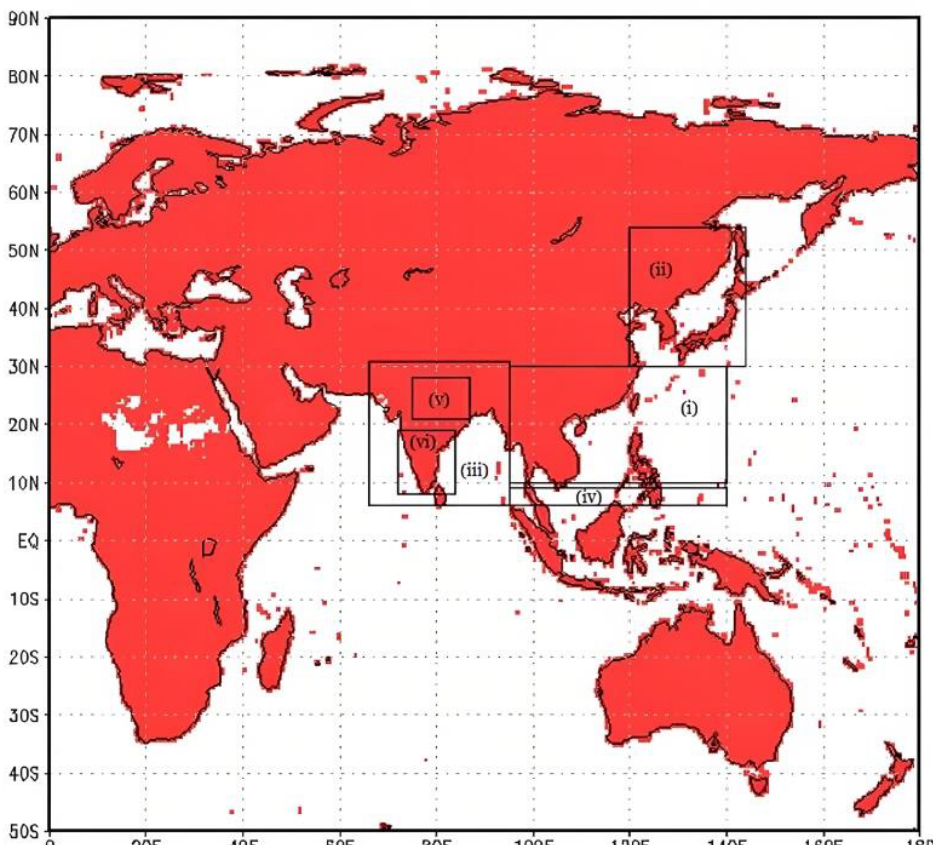
Figure 1. Major rice growing regions of world and its broad zones in boxes depicting (i)SE Asia Rice Growing Region (SEAR) (10° N to 30° N latitude and 95° E to 140° E longitude), (ii) NE Asia Rice Growing Region (NEAR) (30° N to 54° N latitude and 120° E to 144° E longitude), (iii) South Asia_Rice Growing Region (SAR) (6° N to 31° N latitude and 66° E to 95° E longitude), (iv) Maritime Continent Region (MCR) (6° N to 9° N latitude and 95° E to 140° E longitude). Indian subcontinent has been broadly divided into two zones namely (v) Indo Gangetic Plain Region (IGP) (21° N to 28° N latitude and 75° E to 87° E longitude) and (vi) Peninsular India Region (PI) (8° N to 19° N latitude and 72° E to 84° E longitude).